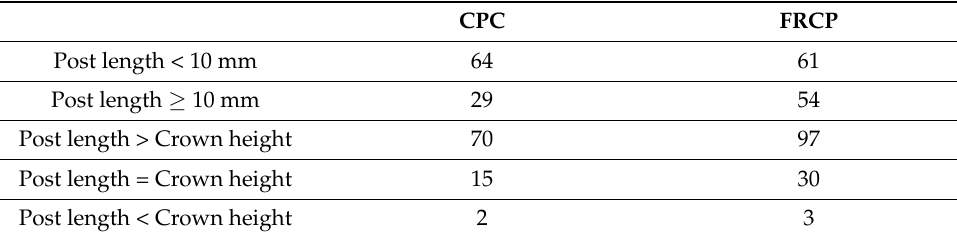
Table 2. Results of measured post length and post-crown